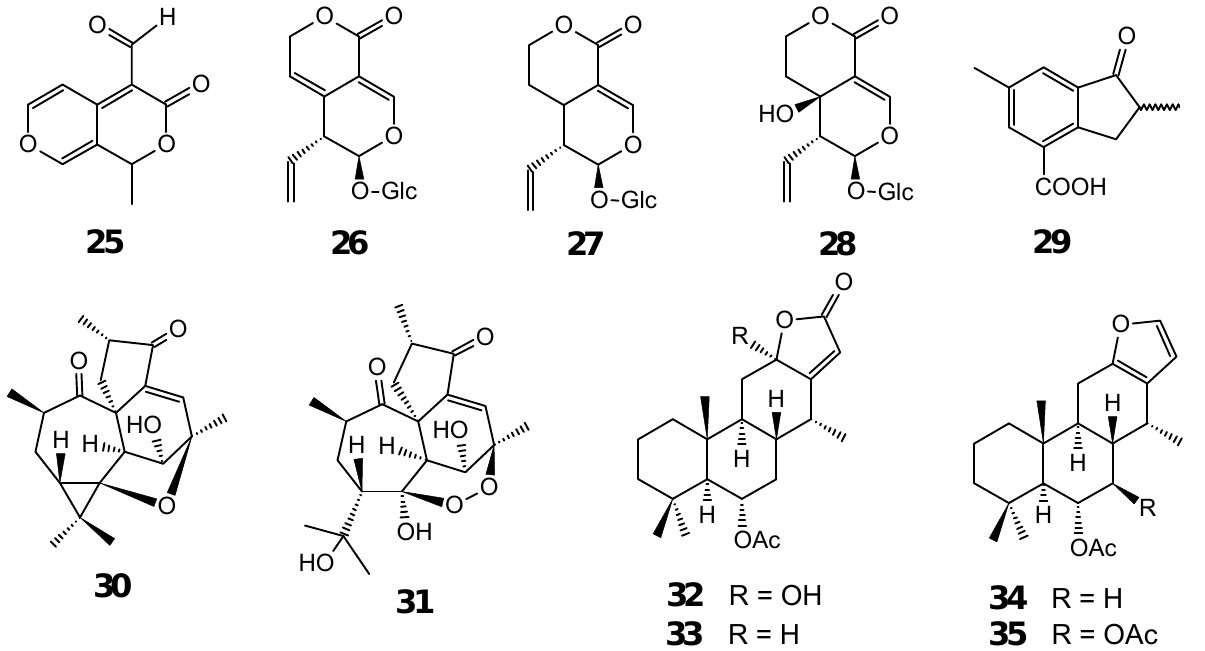
Figure 5. Antiplasmodial terpenes and related compounds 25-35